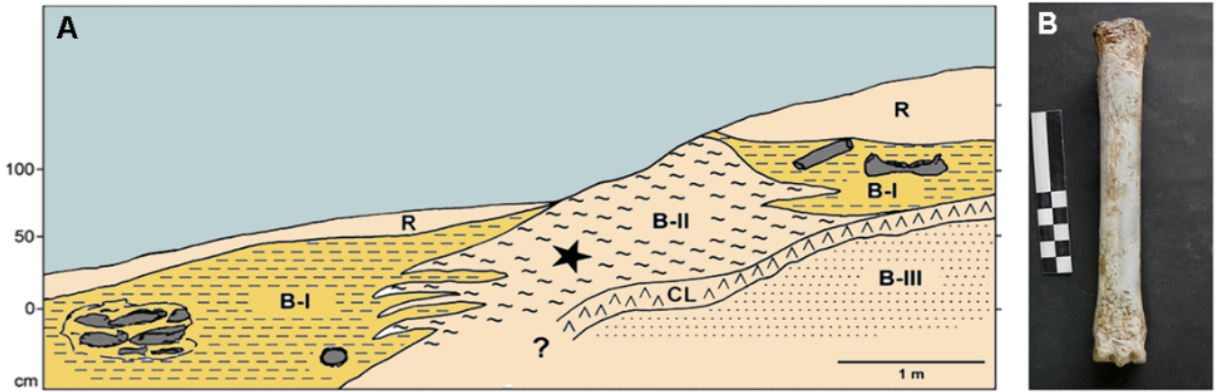
Figure 10. ( A ) NE–SW schematic section of the sedimentary sequence of the B unit deposits cropping out in the β trench. R, recent; B-I, non-concreted B unit; B-II, concreted B unit; B-III; clayey B unit; CL, radiometrically dated concretion with question mark indicating uncertain continuation of the level; grey, partially articulated elephant bones; star, location of the dated Equus hydruntinus (from Ref. [30], modified). ( B ) Metapodial of E. hydruntinus dated at 23–21 ka.